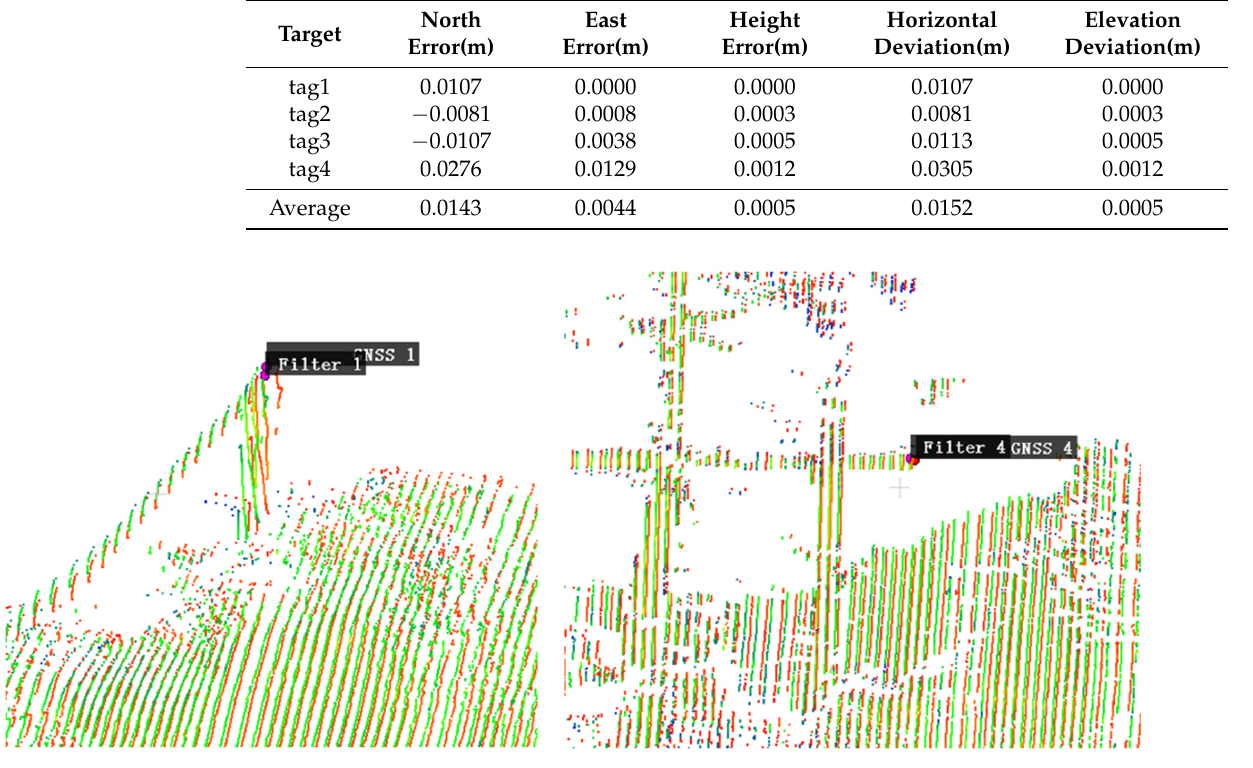
Table 6. Error of the same name point generated by multi-sensor fusion and point cloud generated by integrated navigation.